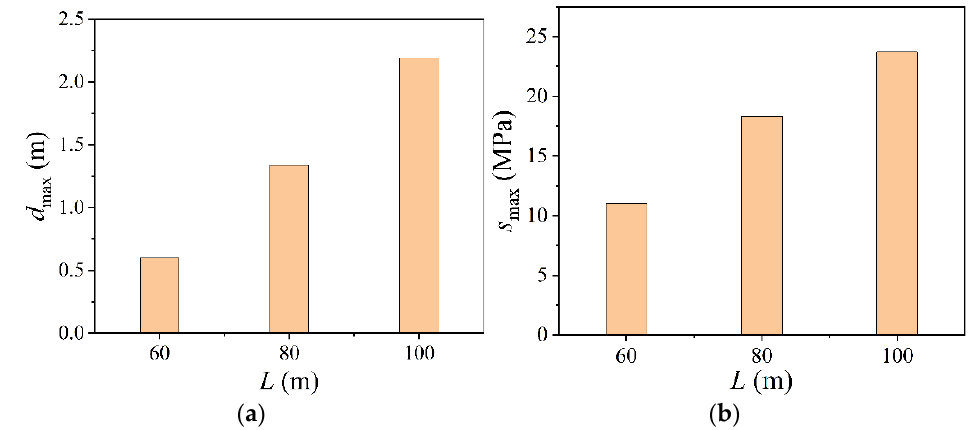
Figure 15. The maximum wind-induced responses with different spans ( H / L = 0.50, p = 300 Pa, U h = 15 m/s): ( a ) Displacement; ( b ) Stress.